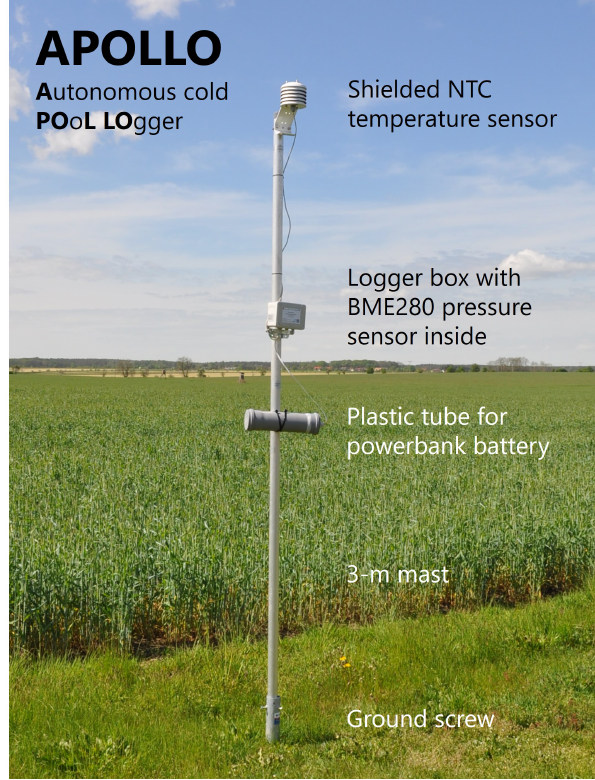
Figure 1. Components of APOLLO station.